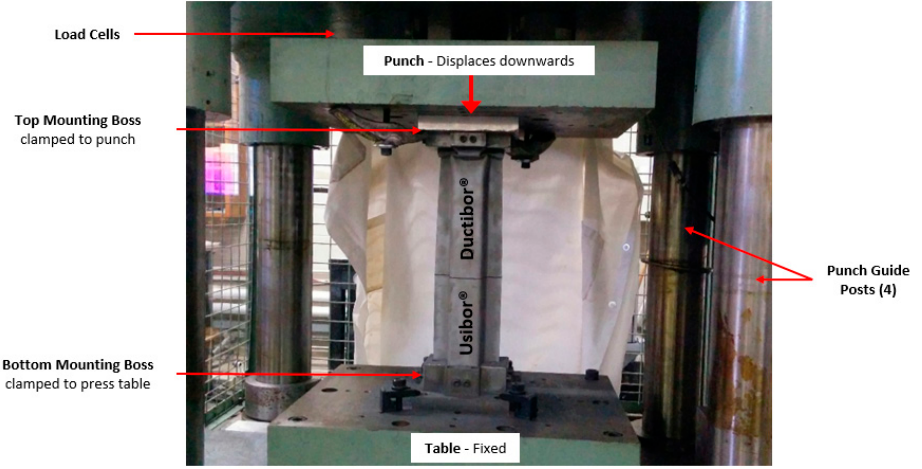
Figure 3. Quasi-static axial crush test setup in hydraulic